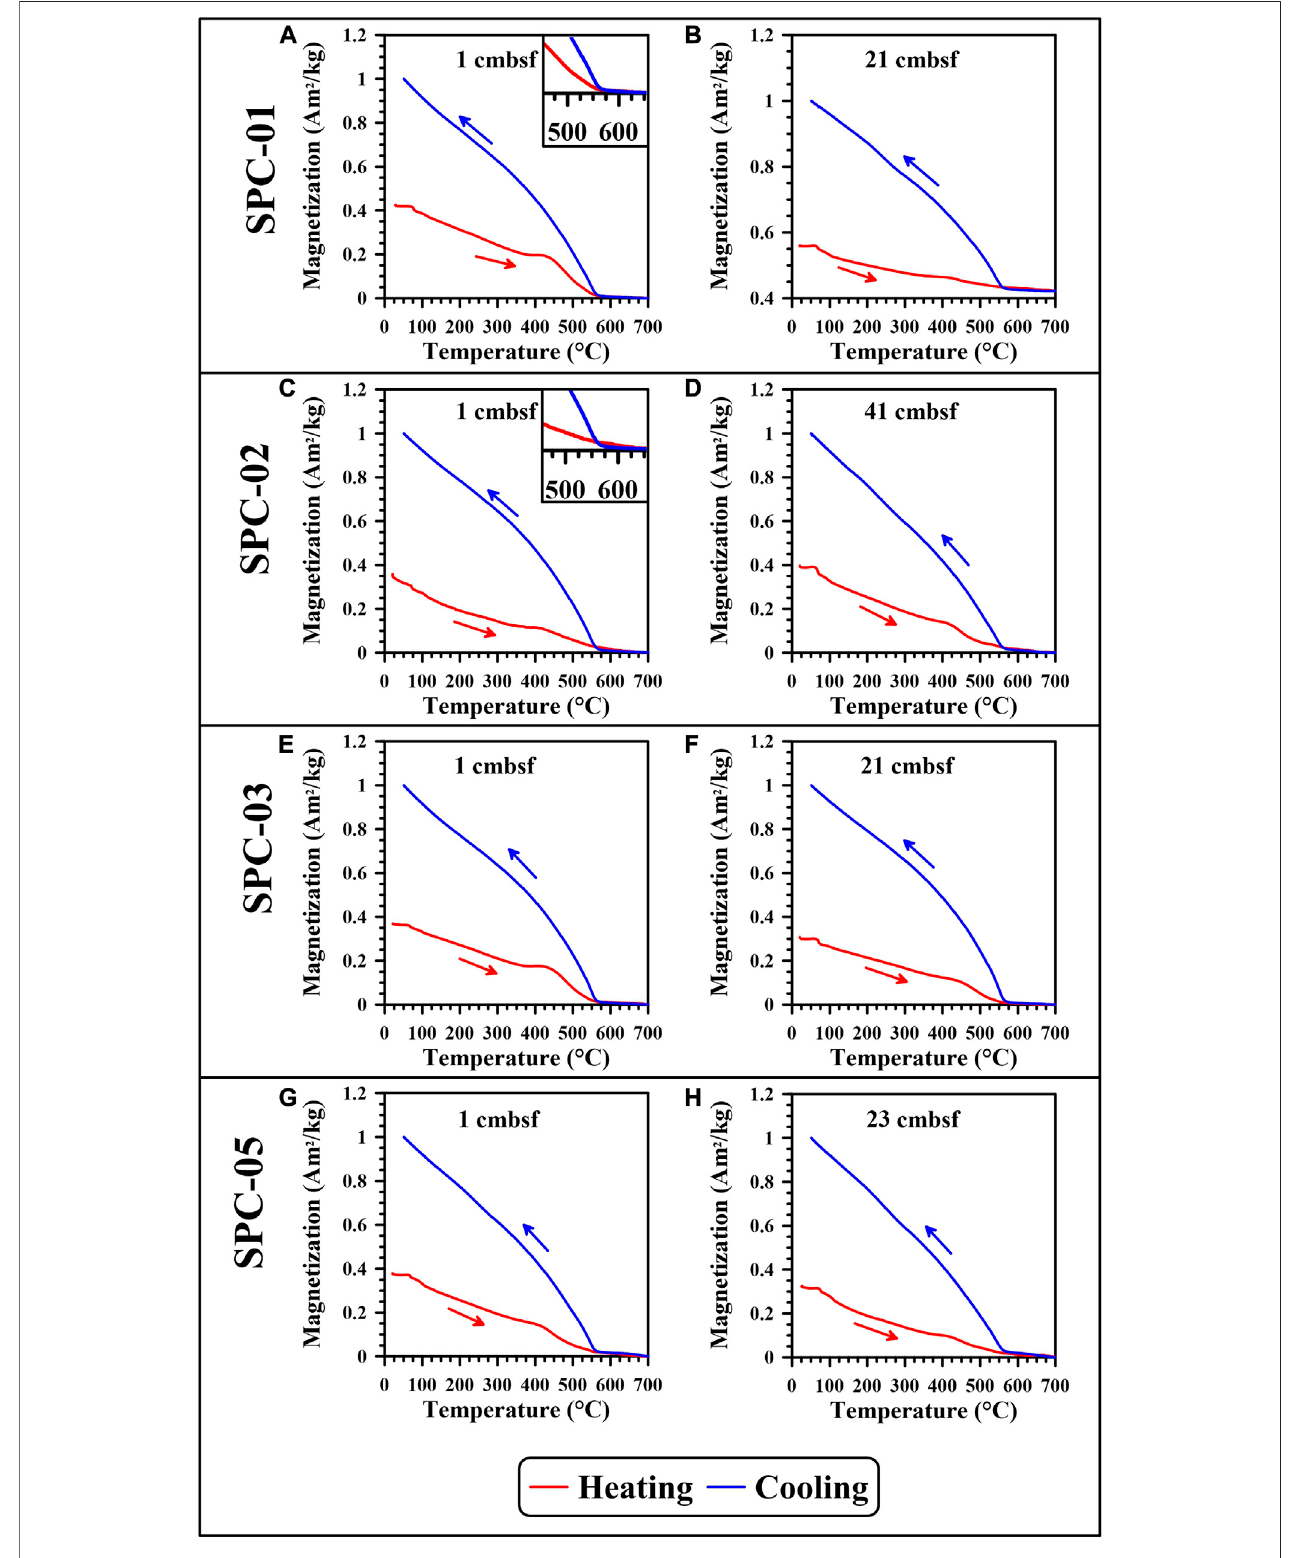
FIGURE 3 | Thermomagnetic pro fi les of selected representative samples representing two sedimentary magnetic zones of the studied spade sediment cores. (A – B) : SPC-01, (C – D) : SPC-02, (E – F) : SPC-03, and (G – H) : SPC-05. Solid red lines indicate heating curves, and blue lines indicate cooling curves respectively.